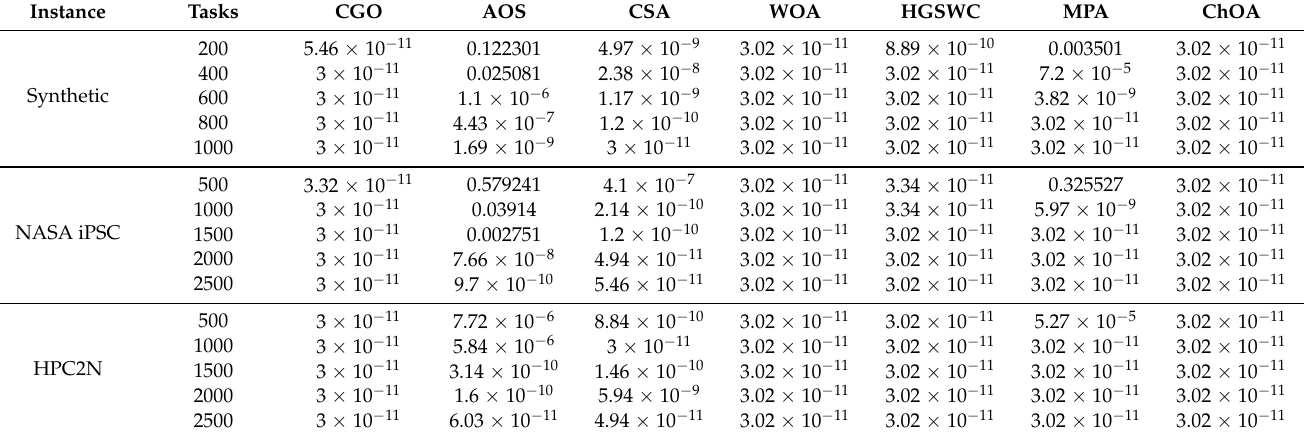
Table 7. Wilcoxon rank test.